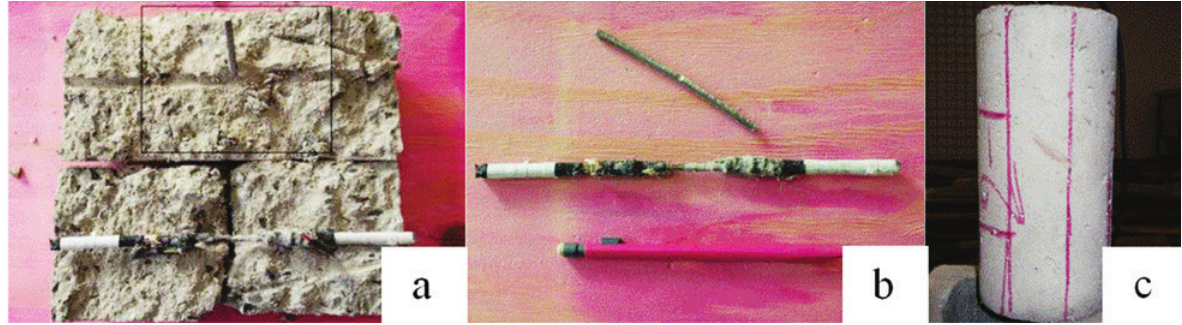
Figura 10 Modo de ruptura da amostra AT1-E